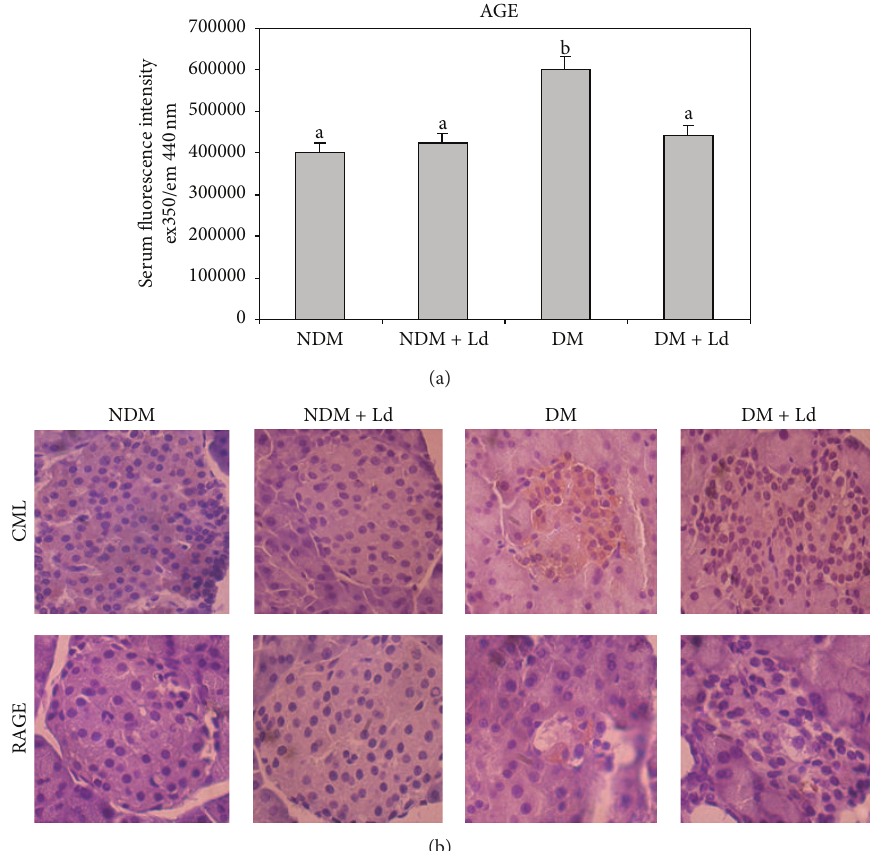
Figure 4: The effect of L. deterrimus administration on AGE in the circulation (a) and presence of CML-modified proteins in pancreatic islets (b). Fluorescent products of AGE in the serum (a). Light photomicrographs of immunohistochemical staining for CML and RAGE of pancreatic sections within the islet (b) (magnification 40x). NDM: control rats; NDM + Ld: control rats treated daily with L. deterrimus extract for four weeks; DM: STZ-induced diabetic rats, DM + Ld: STZ-induced diabetic rats treated with L. deterrimus extract for four weeks. The values are presented as the mean ± S.E.M.; values not sharing a common superscript letter differ significantly at 𝑃 < 0.05 .